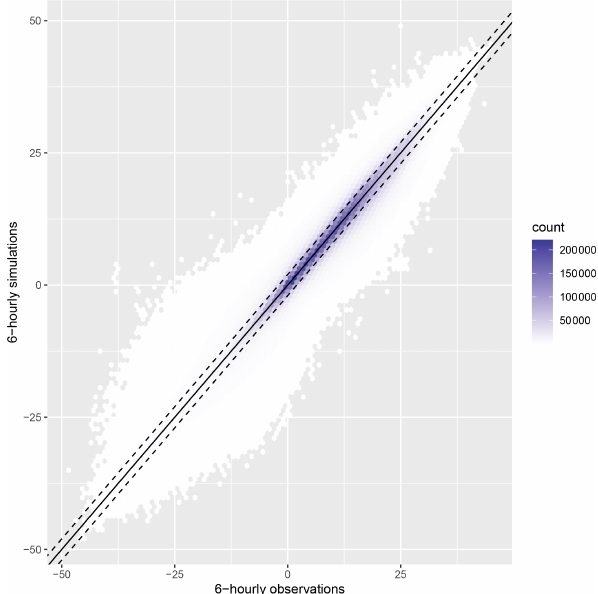
Figure 7. Comparison of observed and simulated 6-hourly temper-